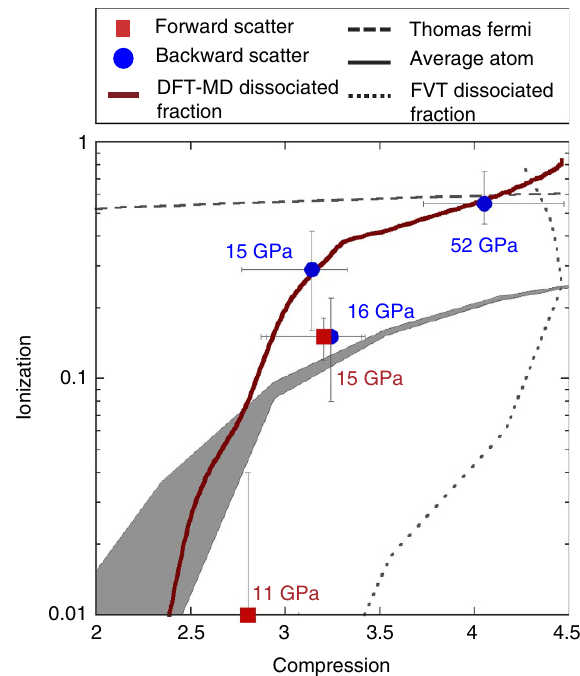
Figure 6 | Average ionization of D 2 plotted as a function of compression along the single-shock Hugoniot. Values of ionization inferred from plasmon measurements are shown as red squares, measurements using Compton scattering are shown as blue circles, and pressures from quotidian EOS (QEOS) are indicated for each data point. Ionization degree calculated with Thomas–Fermi theory is shown as a dashed line, while average-atom calculations are shown between a lower bound of T e ¼ 0.1eV and an upper bound of T e ¼ 0.5eV as a shaded region. The dark red line shows the molecular dissociation fraction calculated from density functional molecular dynamics simulations along the principal Hugoniot and the dotted line shows a similar dissociation calculation with the chemical picture code FVT. Measurements indicate a sharp increase in ionization near 3 (cid:3) compression, consistent with the DFT-MD calculated dissociated fraction.